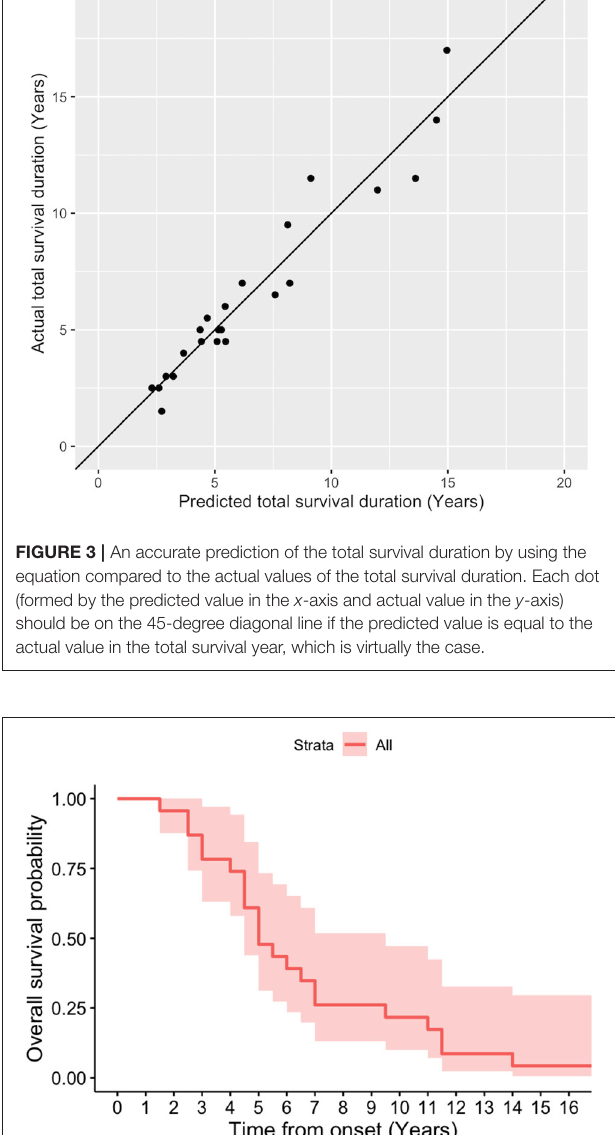
Although the role of the quantitative downgaze palsy in the